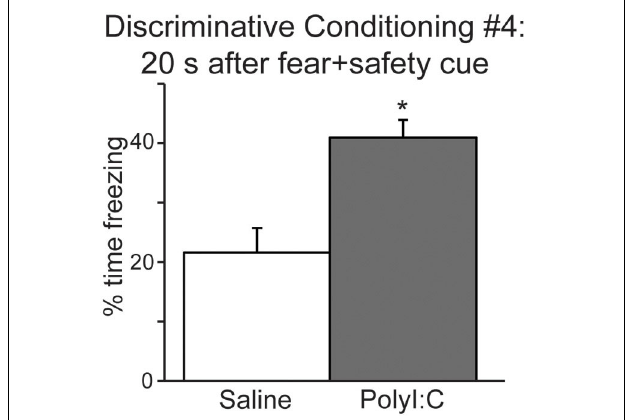
FIGURE 4 | The offspring of polyI:C-treated dams display significantly more freezing during the period following cue offset (20s) in discriminative conditioning session #4. ( ∗ p < 0 .